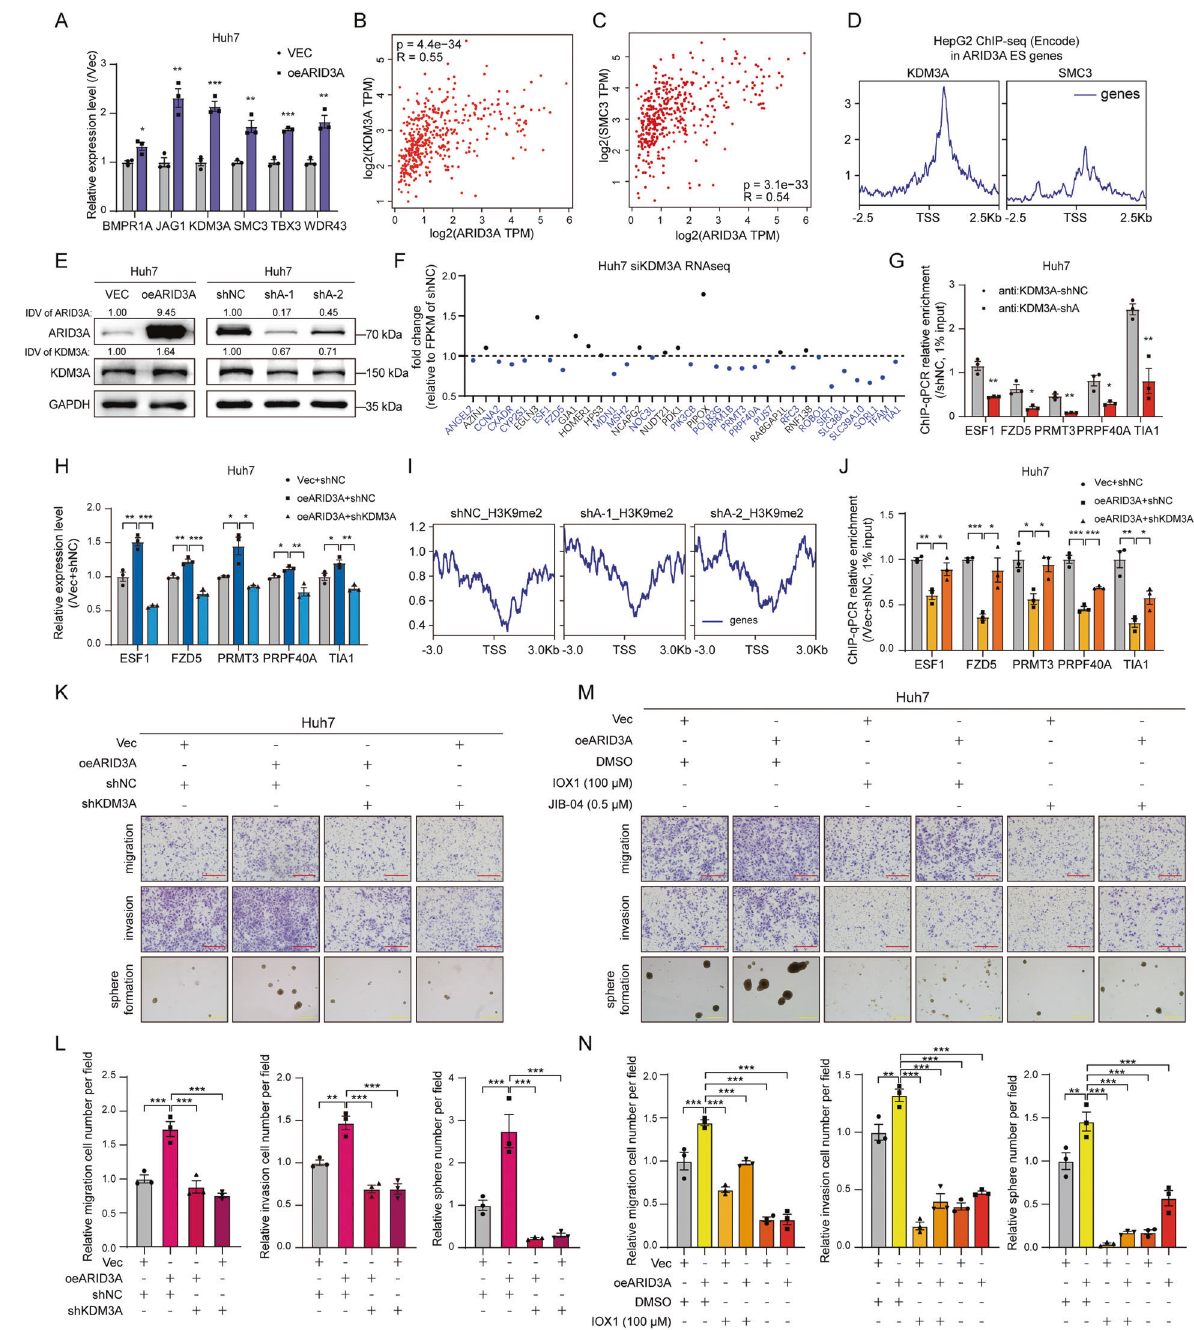
Huh7 and HepG2 cells. The results showed that KDM3A knockdown strikingly decreased the migration, invasion and tumoursphere formation of ARID3A-overexpressing liver cancer cells (Figs. 4K, L and S5A). In contrast, the cell migration, invasion and tumoursphere formation capabilities were obviously restored by KDM3A over- expression in ARID3A-silenced cells (Fig. S5B, C). Moreover, treatment with either of two KDM3A inhibitors, IOX1 and JIB-04, signi fi cantly inhibited cell migration, invasion and tumoursphere formation in ARID3A-overexpressing cells (Figs. 4M, N and S5D). Taken together, these results indicate that KDM3A is a direct downstream effector of ARID3A-mediated regulation of ES signature